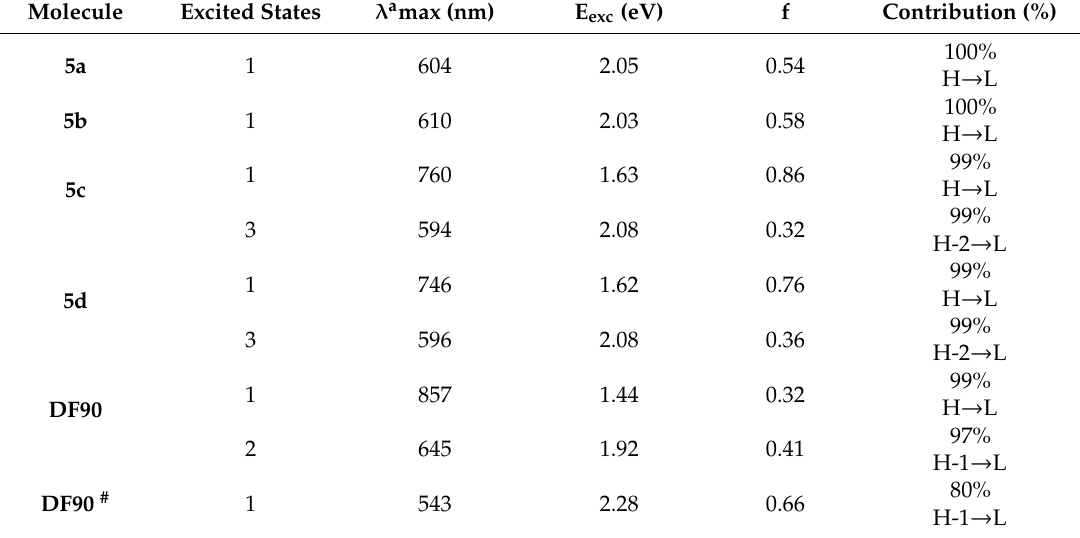
Table 1. TD-DFT (B3LYP / 6-311 ++ G**) absorption maxima ( λ a max), excitation energies (E exc ), oscillator strengths (f) and contribution (%) to the transition in DCM for the lowest excited states having